Question: Which kind of chart has been used to present this data?
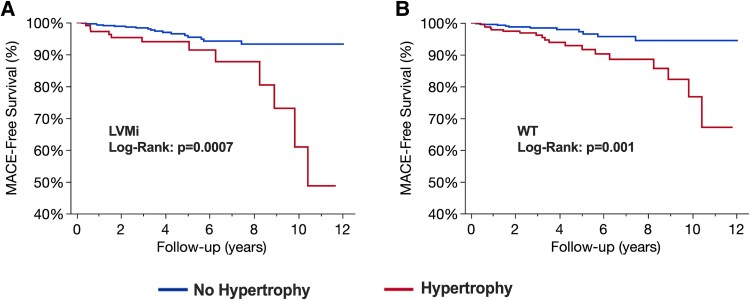
Answer: survival